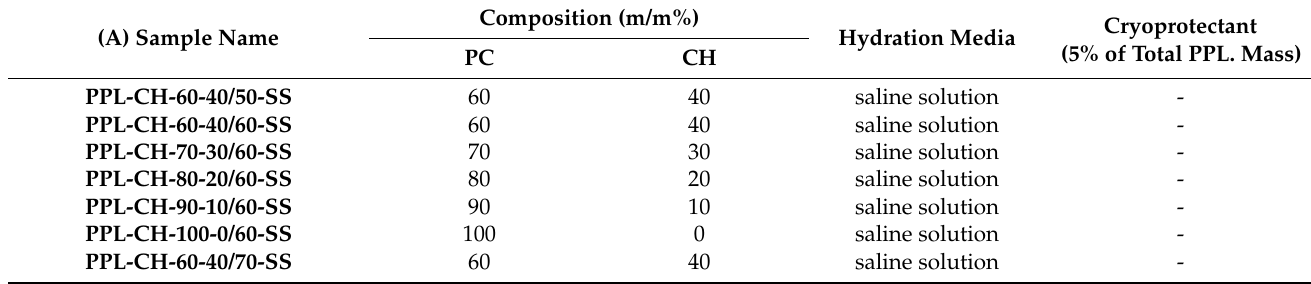
Table 3. Nomenclature of the samples presented in the